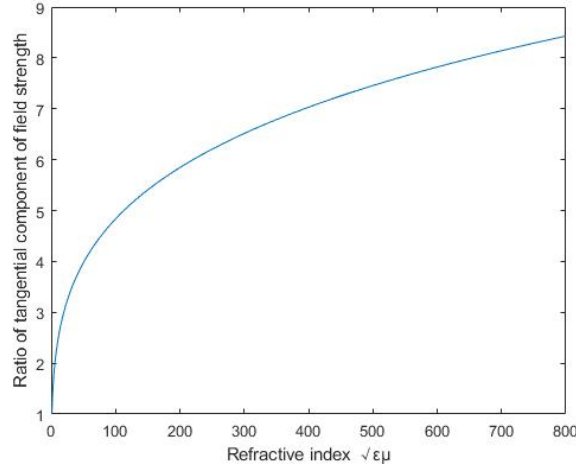
Figure 8. Relationship between field intensity ratio and refractive index.